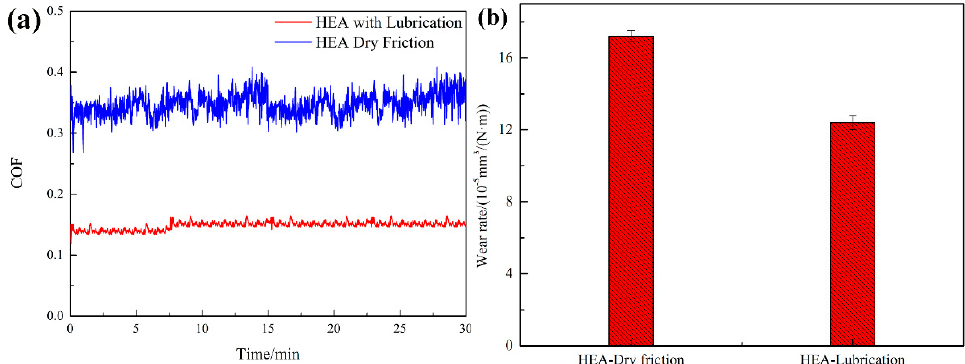
Figure 6. ( a ) Typical friction coefficient curves of the HEA dry wear and HEA with lubrication. ( b ) Wear rate of the HEA dry wear and HEA with lubrication sliding against Al 2 O 3 .